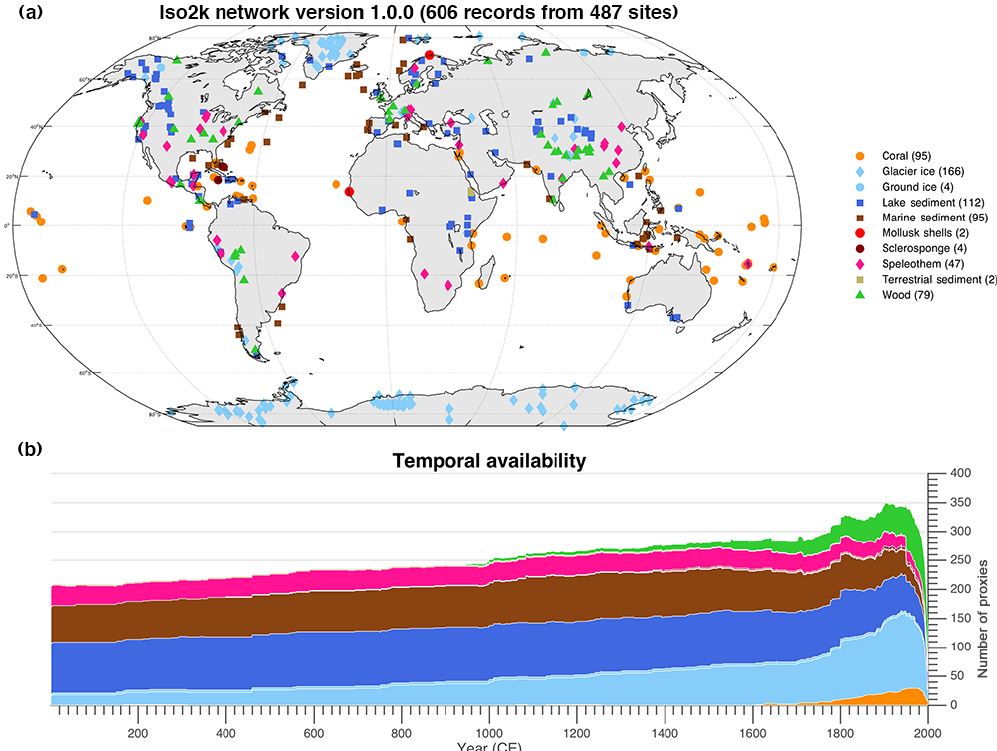
Figure 2. The Iso2k database version 1.0.0. (a) Spatial distribution of “primary time series” records in the Iso2k database. Symbols represent records from different archives. (b) Availability of records in the Iso2k database over time during the past 2000